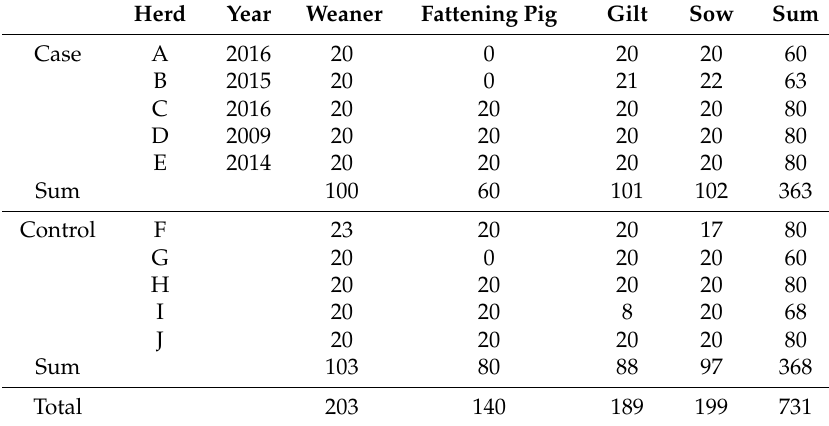
Table 1. Number of samples per herd and age group. The “Year” column denotes the year of and rows denote the number of samples per herd. The rows denoted “Sum” show the number of samples in total per age group for case and control herds,